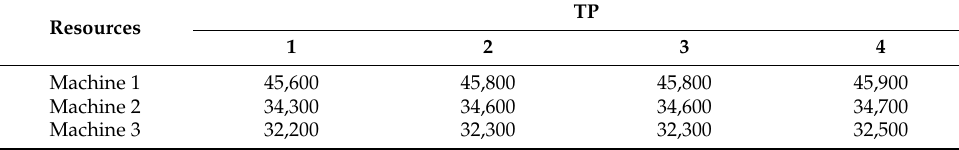
Table 2. Added Resources Cost (IDR/ton).